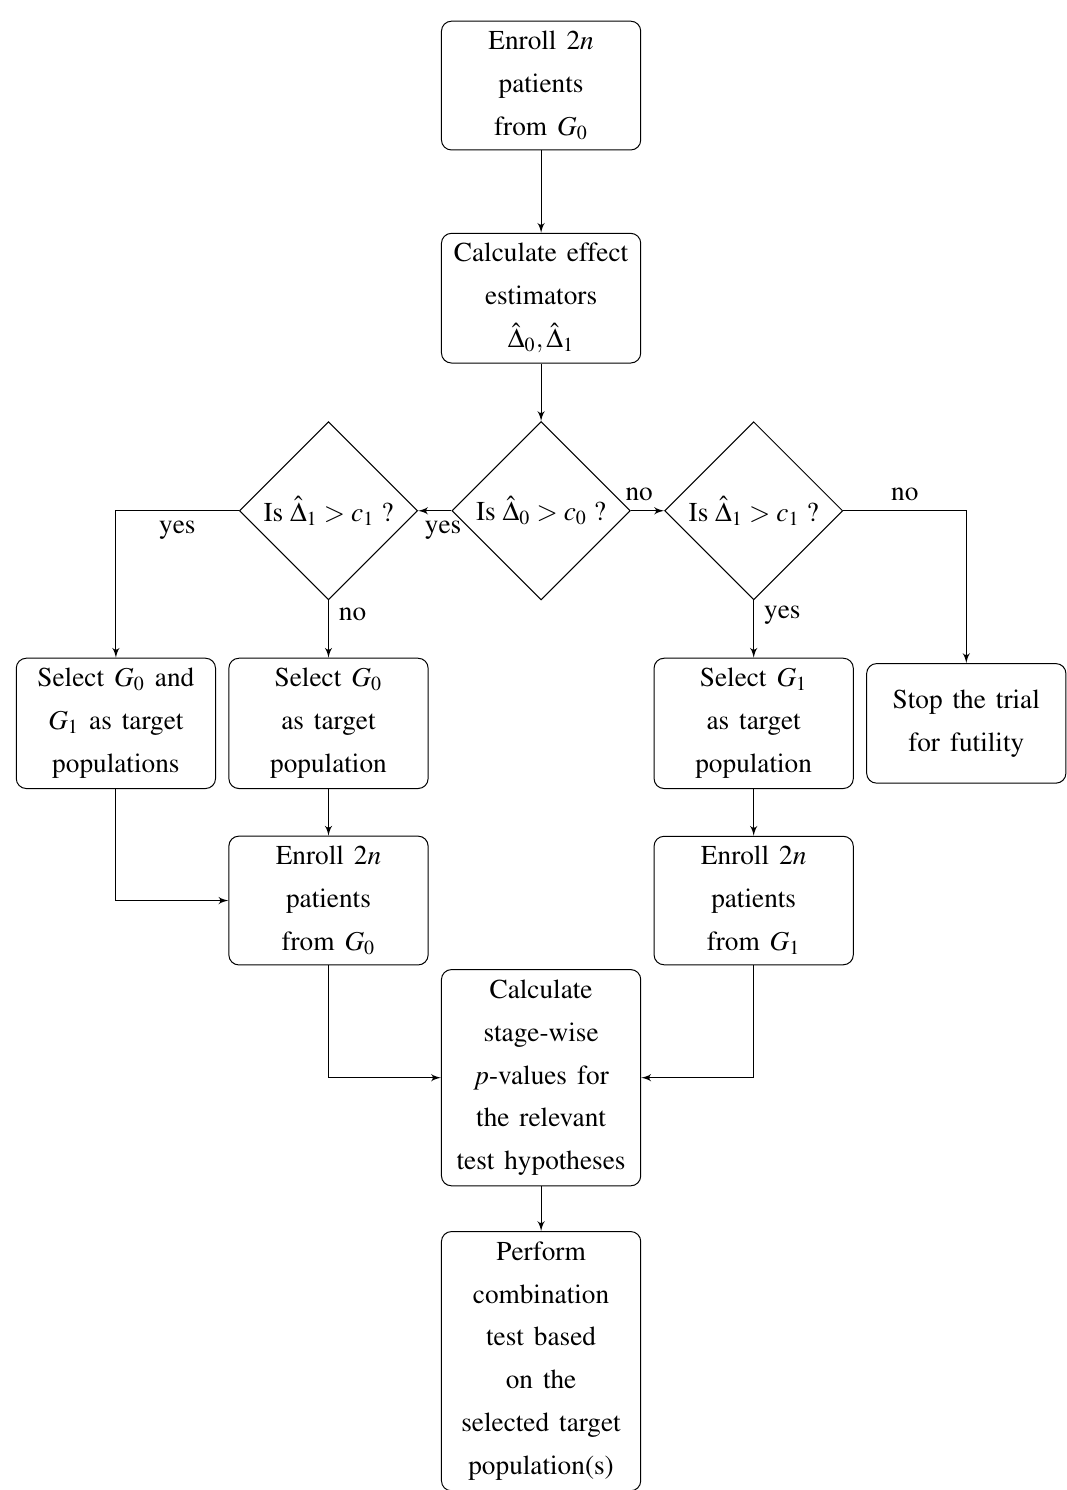
Figure 1. Flowchart of the considered adaptive two-stage